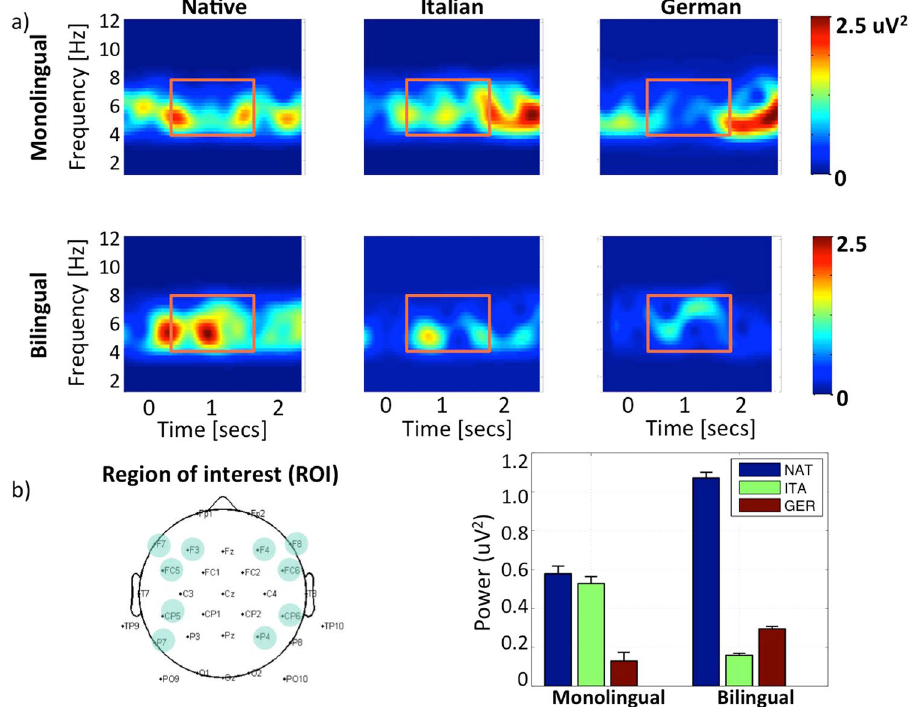
Figure 2. ( a ) Time–frequency power representation of the induced theta response per language and group from 0–12 Hz. For each map, the x-axis represents time (in secs), and the y-axis, frequency (in Hz). Zero corresponds to the onset of the utterances. The color scale codes the variations of power (measured in uV 2 ) with respect to a pre-stimulus baseline. The name of the group is written in the left part of the figure and the language on the top of the figure. The orange box highlights the time window of interest (from 400 ms until 1800 ms). ( b ) (Left) EEG electrodes projections of the ROI on the scalp (blue circles). (Right) Mean power for each language in the Theta band from 400 to 1800 ms. The y axis represents the power (uV 2 ) from 0 to 1.2 and the x axis represent both the monolingual and the bilingual group. For each group, the mean power is plotted in each bar, the blue bar represents the mean values for the native language, the green for Italian and the red for German. Note: for a better visualization, TFR plots have been preprocessed separately using two filters in the frequency domain: a band pass filter (4–8 Hz) and band stop filter (8–20